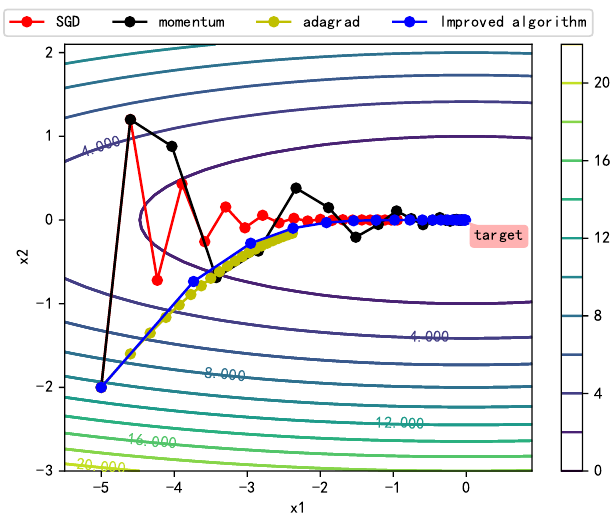
Figure 4. Changes of the gradient vector in the contour curve.